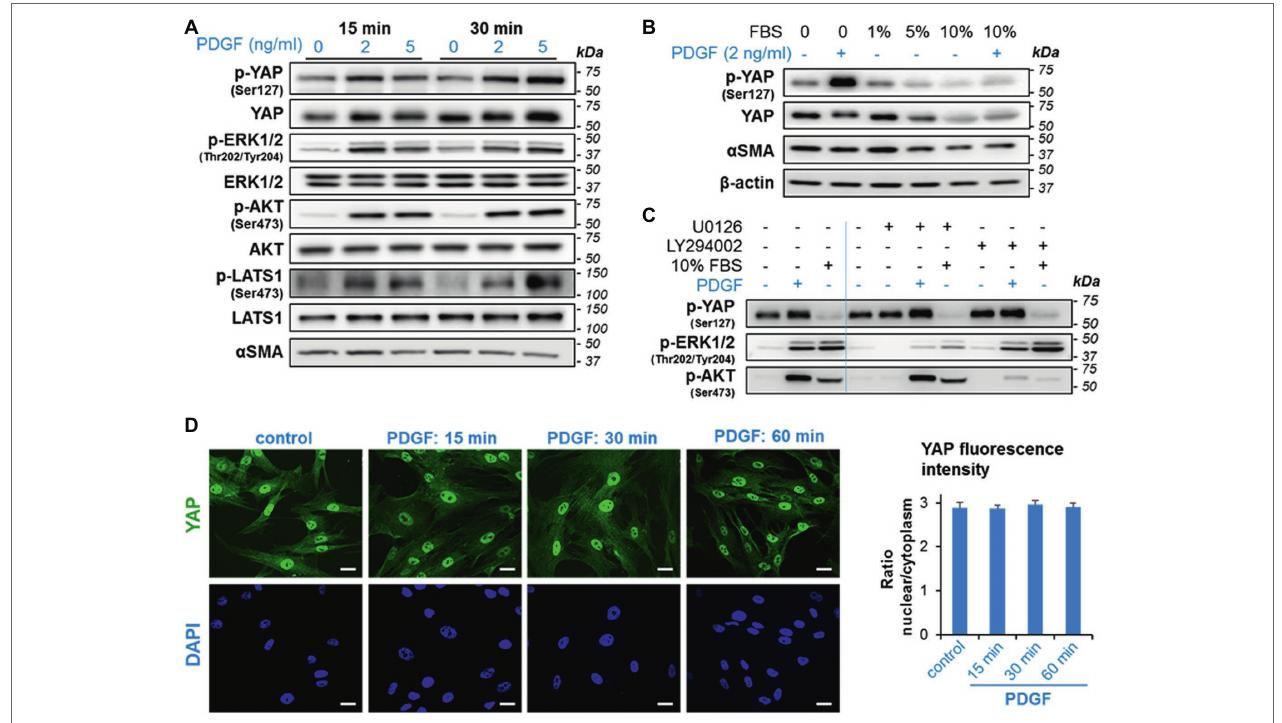
FIGURE 5 | PDGF induces rapid phosphorylation of YAP and activation of growth signaling in imPaSC. (A) imPaSC cultured in DMEM containing 10% FBS, were serum-starved for 12 h and then treated with PDGF (2 and 5 ng/ml) for 15- and 30-min. Levels of total and phosphorylated forms of the indicated targets were measured by western blotting. As shown in the immunoblots, PDGF induced rapid activation of ERK1/2, AKT, and Hippo kinases (LATS1) and significantly increased levels of phosphorylated YAP (at Ser127). (B) Cells cultured in DMEM containing 10% FBS were serum-starved for 12 h and then cultured in media containing different concentrations of FBS. Twenty-four hours later, cells were treated for 30 min with and without 2 ng/ml PDGF. As shown in the immunoblots, 5 and 10% FBS reduced levels of total and phosphorylated YAP while PDGF markedly induced YAP phosphorylation. (C) imPaSC were serum-starved for 12 h, pre-treated with the MEK inhibitor U0126 (10 μ M) or the PI3K/AKT inhibitor LY294002 (20 μ M) for 1 h and then treated with or without 2 ng/ml PGDF or 10% FBS for 30 min. Levels of the indicated targets were measured by Western blotting. (D) Cells treated with 2 ng/ml PDGF for up to 60 min were IF stained using a YAP specific antibody; Scale bar, 50 μ m. Quantified nuclear/cytoplasmic YAP fluorescence intensity is shown in (E) . Fluorescence was measured as indicated in Materials and Methods and expressed as nuclear/cytoplasmic ratio (mean ± SEM, n = 70–90 cells). As shown in the pictures, YAP staining was preferentially located in the nucleus in both control and PDGF-treated cells, and PDGF treatment did not alter YAP nuclear/cytoplasm ratios. Data in panels A–E are representative of three independent